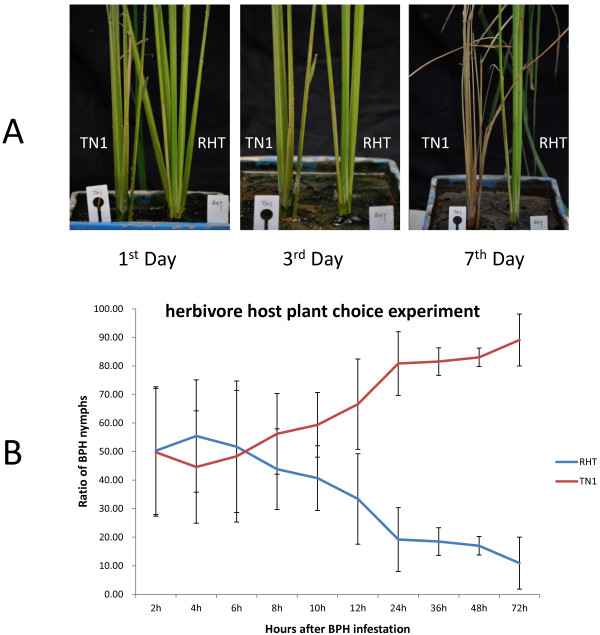
Brown planthopper (BPH) feeding and selection test on rice varieties RHT (resistant) and TN1 (susceptible).A, Phenotypes of RHT and TN1 on days 1, 3, and 7 of BPH infestation. B, BPH host selection experiment between rice varieties RHT and TN1 (72 h).